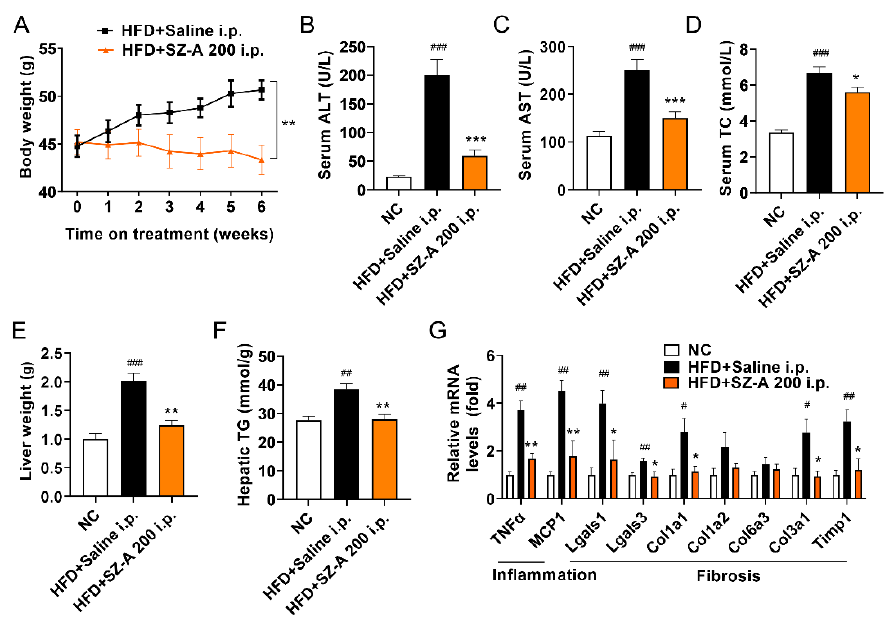
Figure 4. Intraperitoneal administration of SZ-A exerts a protective effect. ( A ) Bodyweight of HFD mice with intraperitoneal administration (i.p.) of saline and SZ-A (200 mg/kg) ( n = 10/group). Effects of SZ-A on serum levels of ALT ( B ), AST ( C ), and CHO ( D ) are shown. Liver weight ( E ) and hepatic triglyceride levels ( F ) of mice are shown. ( G ) Relative mRNA expression of genes involved in inflammation and fibrosis in livers. Data are represented as mean ± SEM. # p < 0.05, ## p < 0.01, ### p < 0.001 compared with the NC group (i.p.), and * p < 0.05, ** p < 0.01, *** p < 0.001 compared with the HFD group (i.p.). NC, normal control; HFD, high-fat diet; SZ-A, Ramulus Mori (Sangzhi) alkaloids;